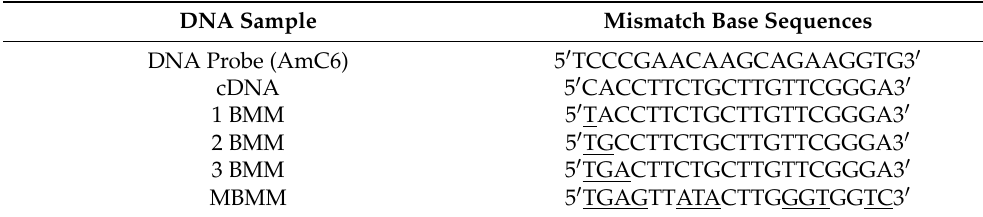
Table 1. The nucleotide sequence of the 5 (cid:48) amino-linked single stranded ssDNA probe, its comple- mentary DNA, and mismatched